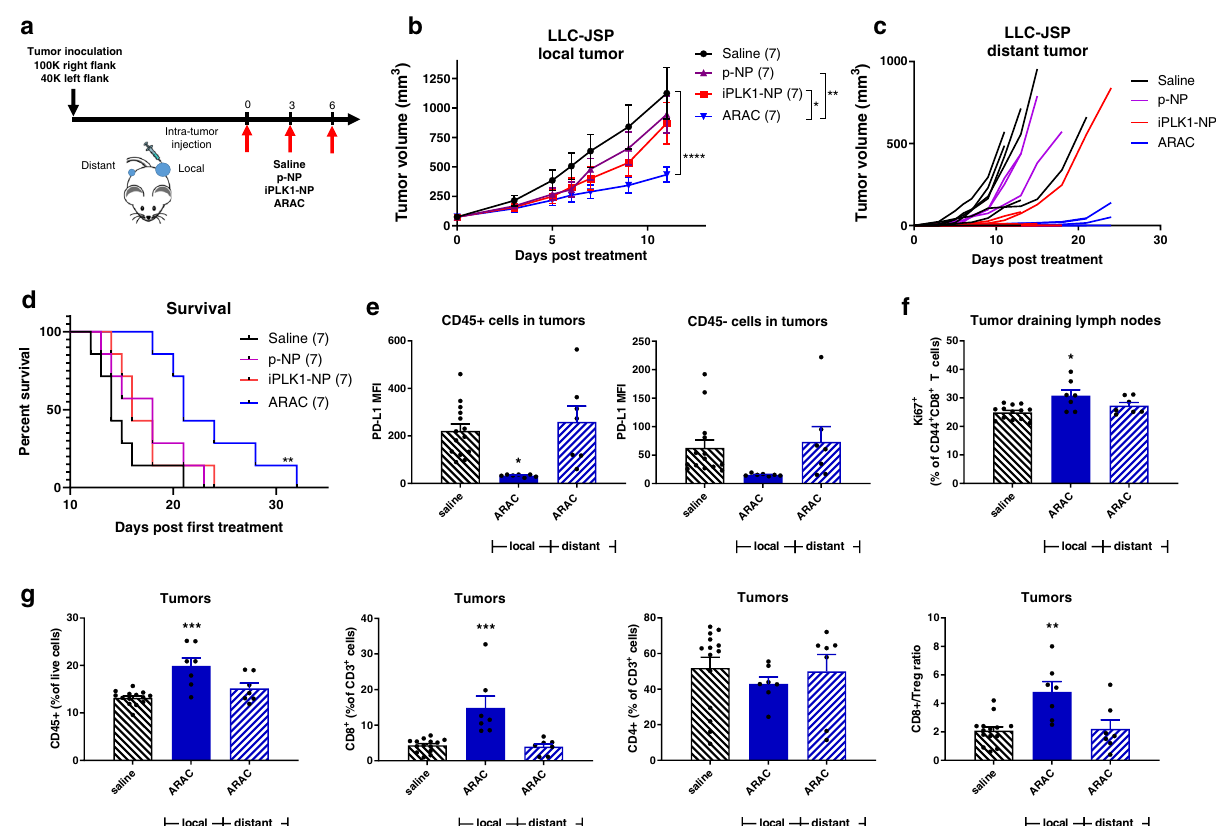
Fig. 5 ARAC elicits anti-tumor immune effects. a 100,000 LLC-JSP cells were injected in right fl ank and 40,000 cells were injected in left fl ank of C57BL/ 6 mice. On day 12 post tumor inoculation, mice ( n = 7 per treatment group) received intratumoral treatments of saline, p-NP, iPLK1-NP, or ARAC to the right (local) tumor. Each dose consists of 0.5 mg NP (containing 2.5 µ g volasertib and/or 20 µ g PD-L1 antibody) in 50 µ l per dose for 3 doses total. b Local (treated) tumor growth. Data presented as mean ± SEM; * P = 0.0104, ** P = 0.0017, **** P < 0.0001 (Two-Way repeated measures ANOVA with Tukey ’ s correction for multiple comparisons). c Distant (untreated) tumor growth of individual mice (distant tumors developed in 6/7 saline, 3/7 p-NP, 3/7 iPLK1- NP, and 2/7 ARAC at shown time-points). d Kaplan – Meier Survival curve (mice were euthanized when a combined tumor size reached 2000 mm 3 ). ** P = 0.0036 for ARAC vs. saline (Log-rank Mantel – Cox test). e – g Mice ( n = 7) were inoculated with 250,000 and 100,000 LLC-JSP cells for bilateral tumors and treated as shown in ( a ) with ARAC or saline. One day post 3rd injection, tumors were harvested and processed into single cell suspensions for fl ow cytometry analysis. e PD-L1 expression (median fl uorescent intensity; MFI) in CD45 + and CD45 − cells. f Proliferative effector T cells (%Ki67 of CD44 + CD8 + cells) in tumor-draining lymph nodes. g CD45 + (% of live cells), CD8 + (% of CD45 + CD3 + cells), CD4 + (% of CD45 + CD3 + cells), and CD8 + /Treg (Regulatory T cells; CD4 + FoxP3 + (% of CD45 + CD3 + cells)) in tumors. Data presented as mean ± SEM; *P < 0.05, ** P < 0.01, *** P < 0.001 (One-Way ANOVA with Tukey ’ s correction for multiple comparisons). Source data are provided as a Source Data fi were grouped ( n = 7) and treated i.v. with 50 mg/kg ARAC (for 4 doses on days 0, 3, 9, 12), i.p. with ICIs (PD-1 and CTLA-4